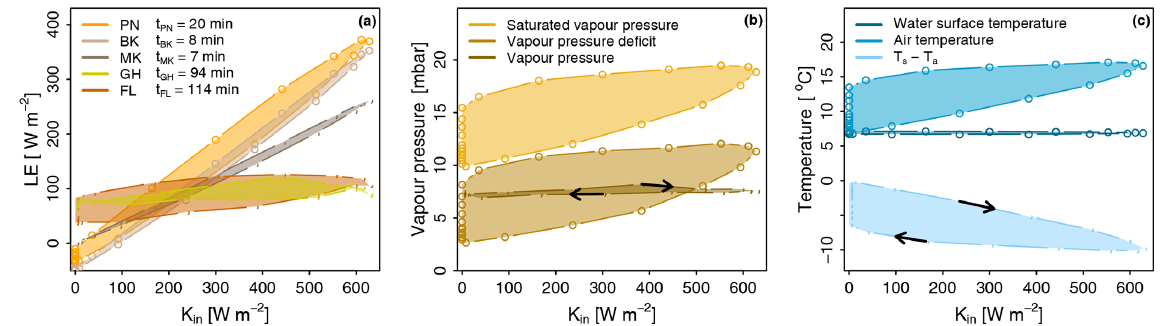
Figure 4. Phase differences of evaporation variables in response to global radiation, illustrating latent heat flux (a) , vapour pressure (b) , and temperature (c) responses to global radiation. Differences are calculated for one day in March 2007. The legend displays the daily phase lag in minutes. The directions of all hysteresis loops are anti-clockwise, indicating a positive phase lag with respect to global radiation, except for the two loops that have a clockwise direction indicated by a black